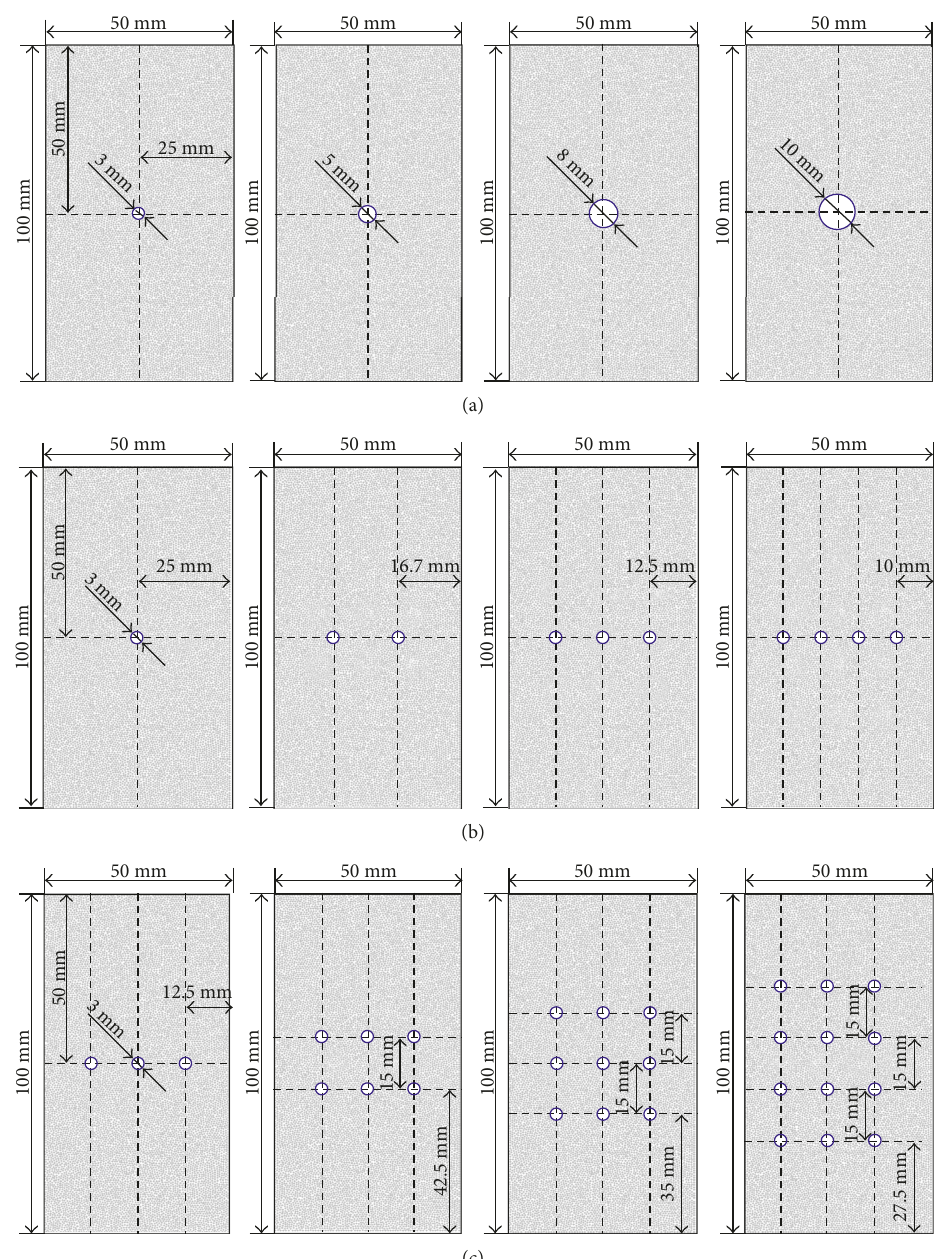
Figure 2: Schematic diagram of test schemes. (a) Specimens with different drilling diameters. (b) Specimens with different numbers of drilling holes. (c) Specimens with different numbers of drilling